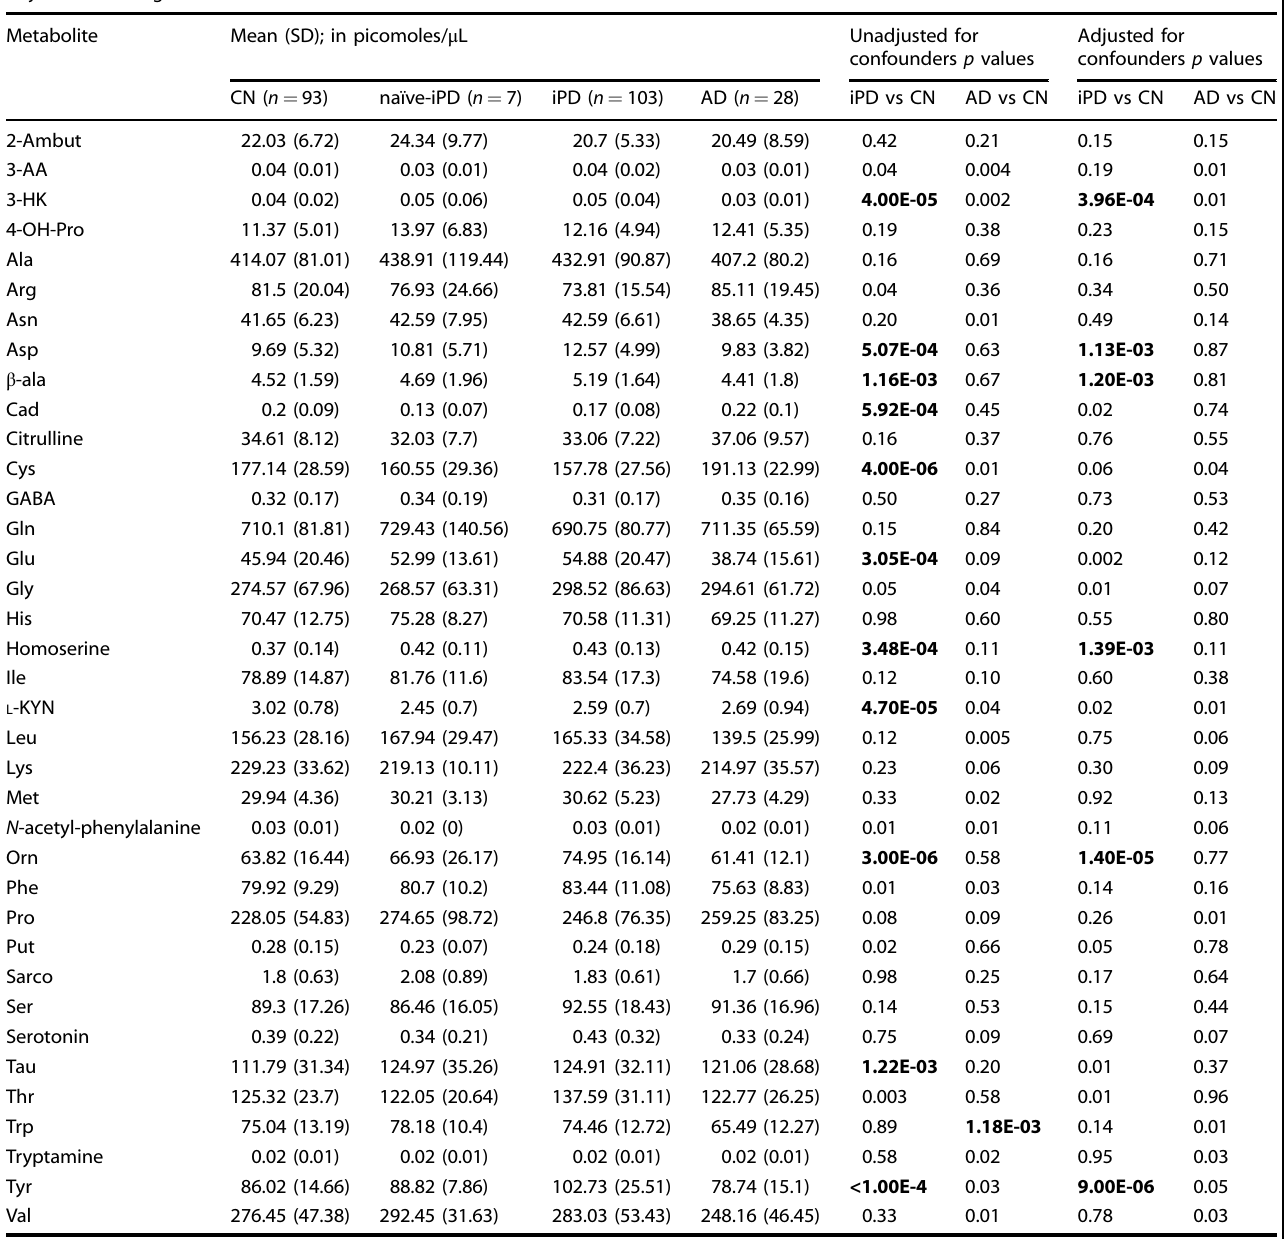
Table 1. Mean metabolite concentrations (pmol µL − 1 ) with standard deviations (SD) and results of pairwise comparison prior and after the adjustment for age and